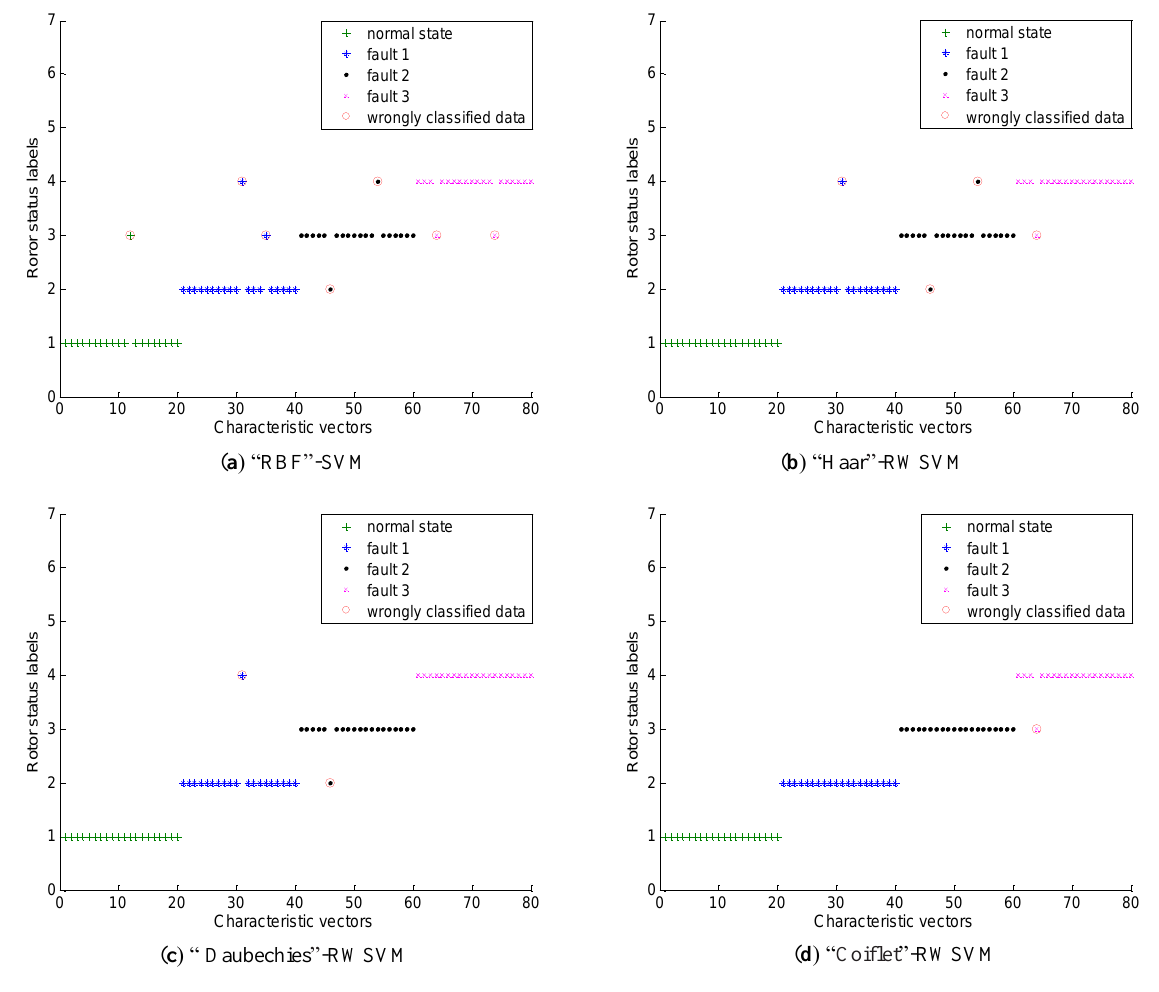
Figure 13. Results of the SVM classification for the aero-engine rotor.